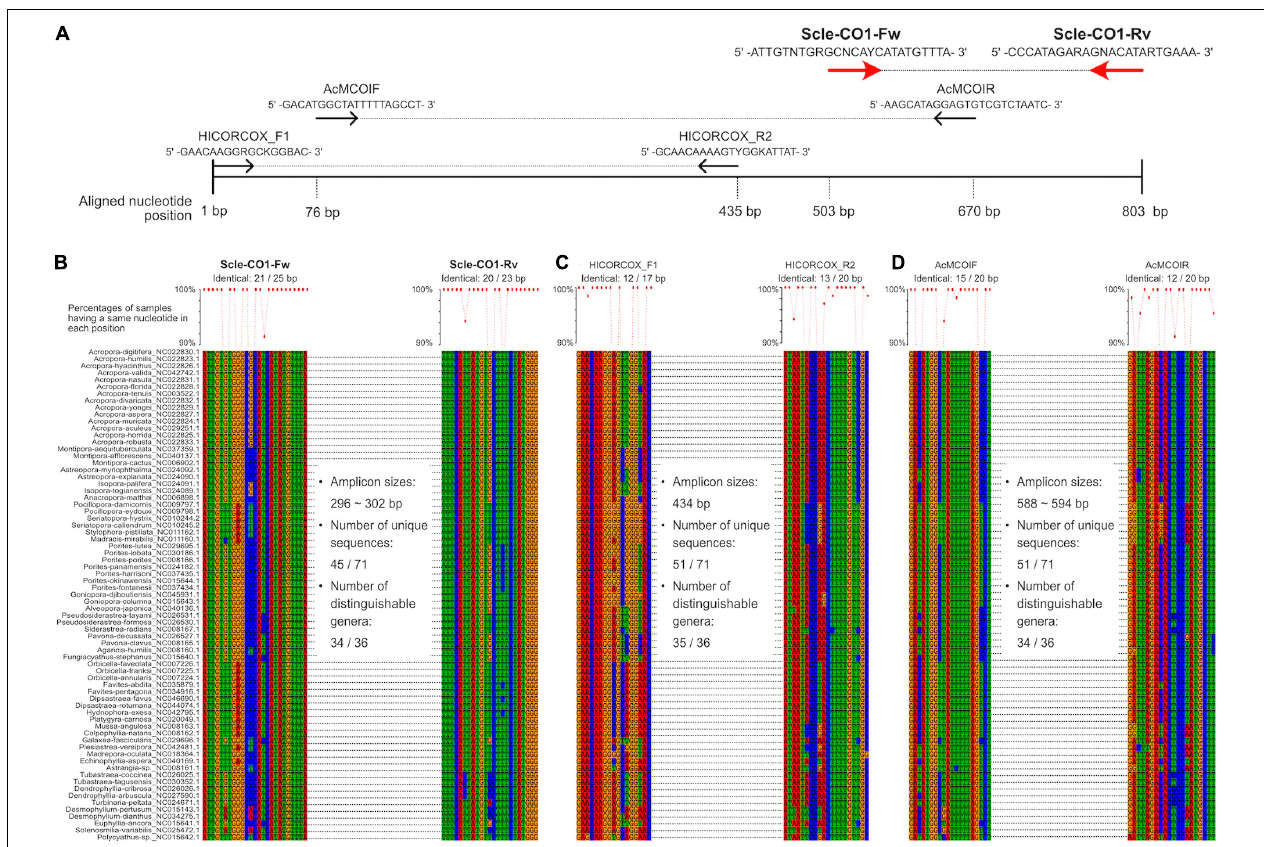
FIGURE 2 | Development of universal primer pairs, Scle-CO1-Fw and Scle-CO1-Rv, to amplify scleractinian cytochrome c oxidase subunit I genes (CO1). (A) Schematic representation of primer sequences, positions of primer binding sites in aligned CO1 genes, and comparisons with previously reported universal primers (AcMCOIF and AcMCOIR) (Fukami et al., 2008) and metabarcoding primers (HICORCOX_F1 and HICORCOX_R2) (Nichols and Marko, 2019). Positions of the designed primers (Scle-CO1-Fw and Scle-CO1-Rv) are shown with red arrows. (B) Nucleotide sequence alignments of expected Scle-CO1-Fw and Scle-CO1-Rv primer binding sites among the 71 scleractinian mt genomes. (C) Nucleotide sequence alignments of expected HICORCOX_F1 and HICORCOX_R2 primer binding sites among the 71 scleractinian mt genomes. (D) Nucleotide sequence alignments of expected AcMCOIF and AcMCOIR primer binding sites among the 71 scleractinian mt genomes. Numbers of identical nucleotides in primer binding sites among the 71 scleractinians are shown, and percentages of samples having the same nucleotide in each primer position are shown in a line graph (more than 90% are shown as